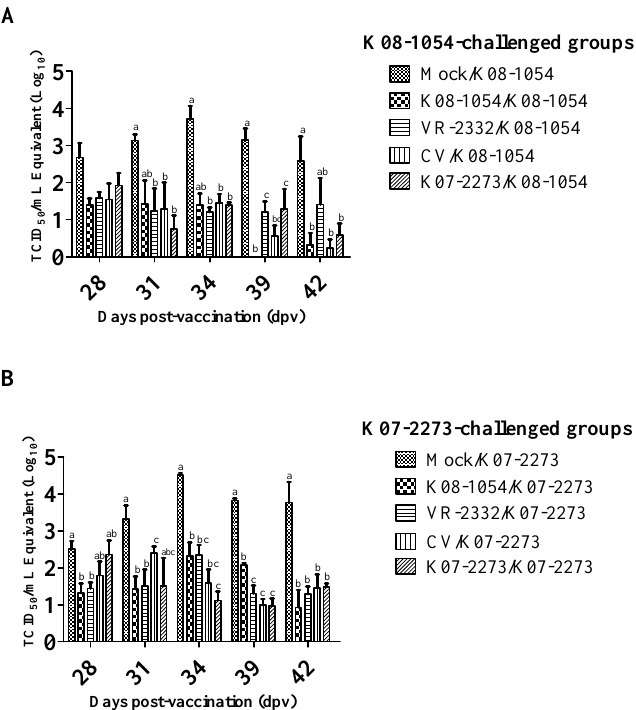
Figure 7. The levels of viremia after virus challenge at 28, 31, 39 and 42 dpv. Serum virus titers of K08-1054-challenged groups at 28, 31, 34, 39, and 42 dpv ( A ) and serum virus titers of K07-2273-challenged groups at 28, 31, 34, 39, and 42 dpv ( B ). The virus titers were calculated based on the standard curve of threshold cycle number plotted against the known virus titer of VR-2332. The bars represent the means, and the error bars represent the standard errors of the mean (SEM). Bars showing different letters represent values significantly different from each other ( p < 0.05).